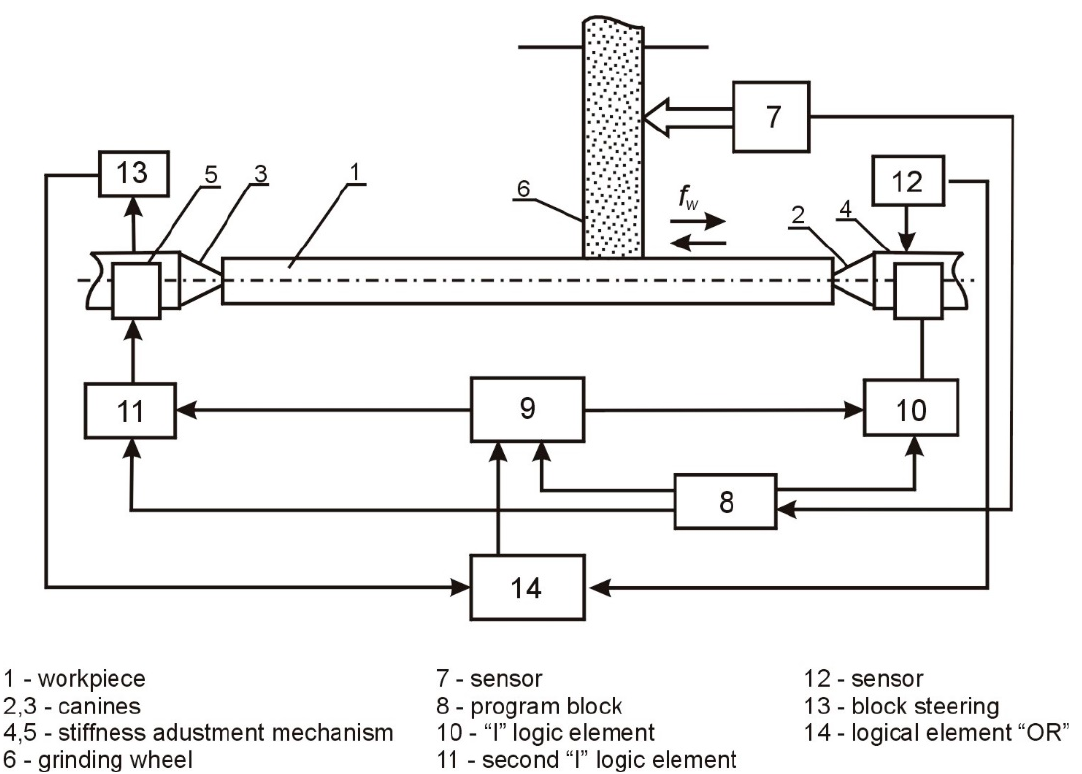
Figure 1. Diagram of the adjustment system of the technological system’s compliance during grinding.